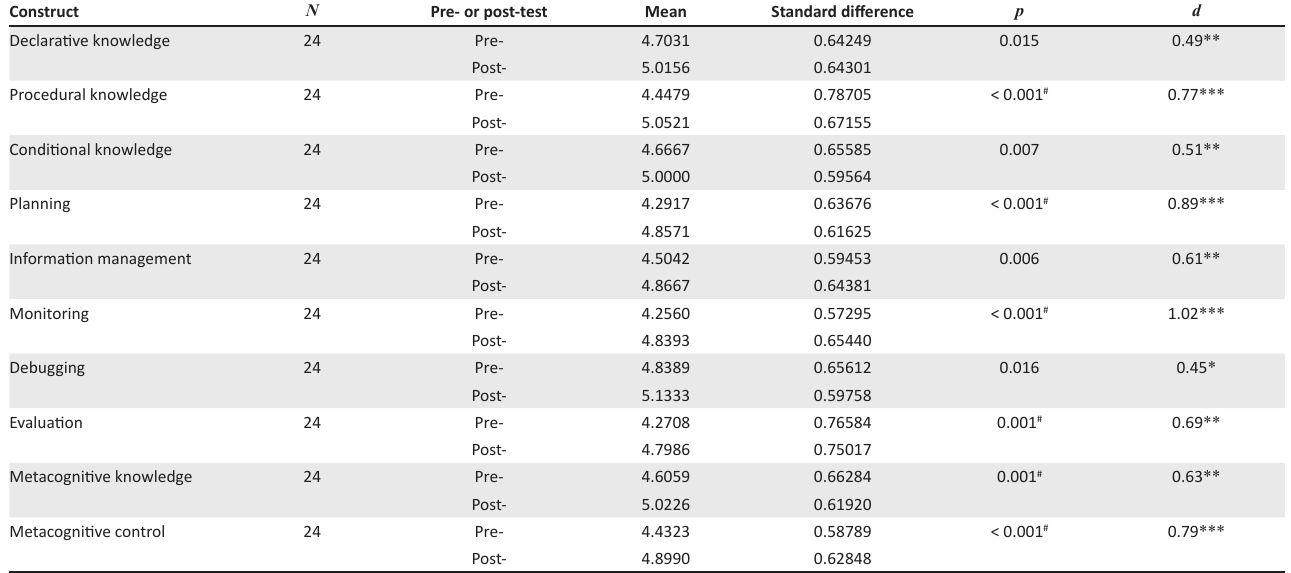
TABLE 1: Metacognitive awareness inventory – Pre-test and post-test.